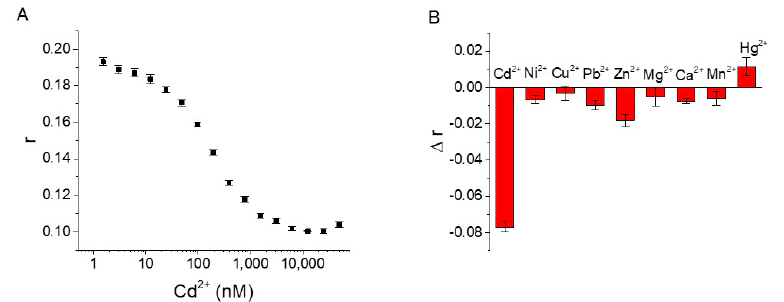
Figure 6. ( A ) FA detection of Cd 2+ using CBA15-G3S-T12-TMR. ( B ) Selectivity test of the FA sensor using CBA15-G3S-T12-TMR for Cd 2+ detection. A 20 nM aptamer probe was used, and the concentrations of tested metal ions were 1000 nM.